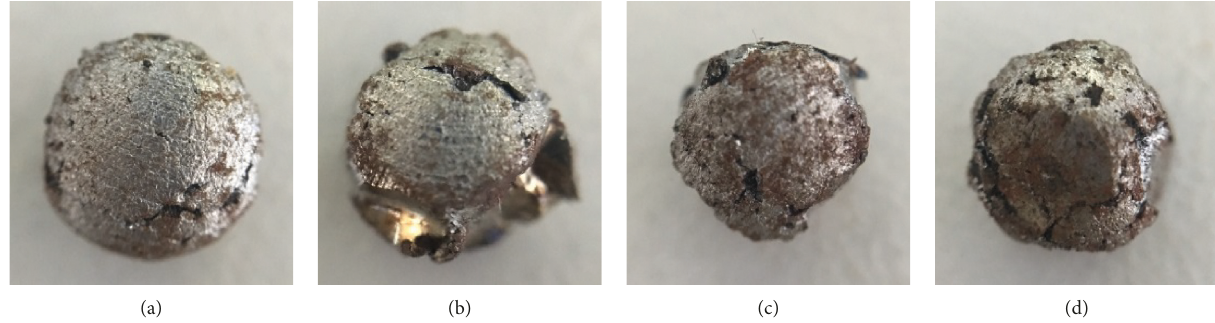
Figure 10: Fracture situation in the skin of the plugs. (a) Q235-Blunt-12. (b) Q235-Blunt-6. (c) Q235-Blunt-3. (d)